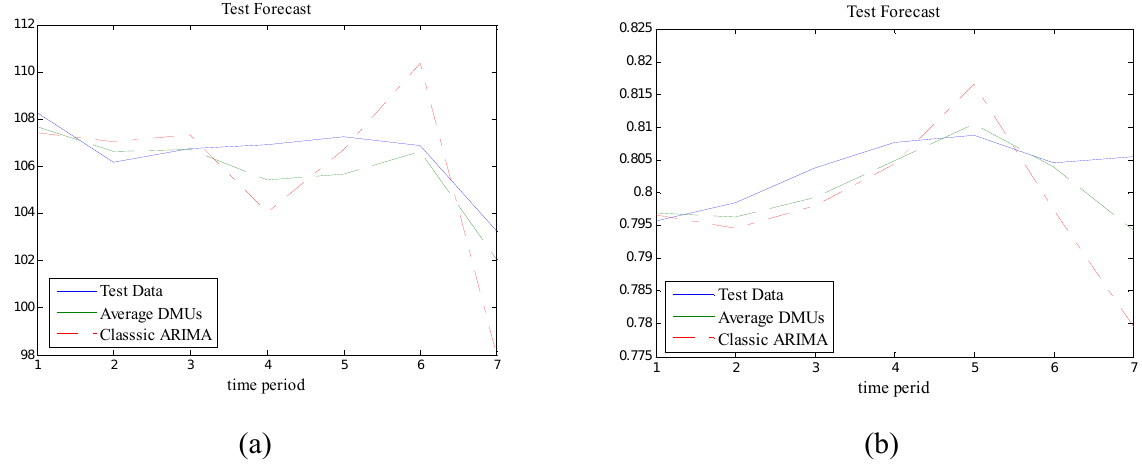
Fig. 4. Forecasted and Test data for (a) Brent oil and (b)